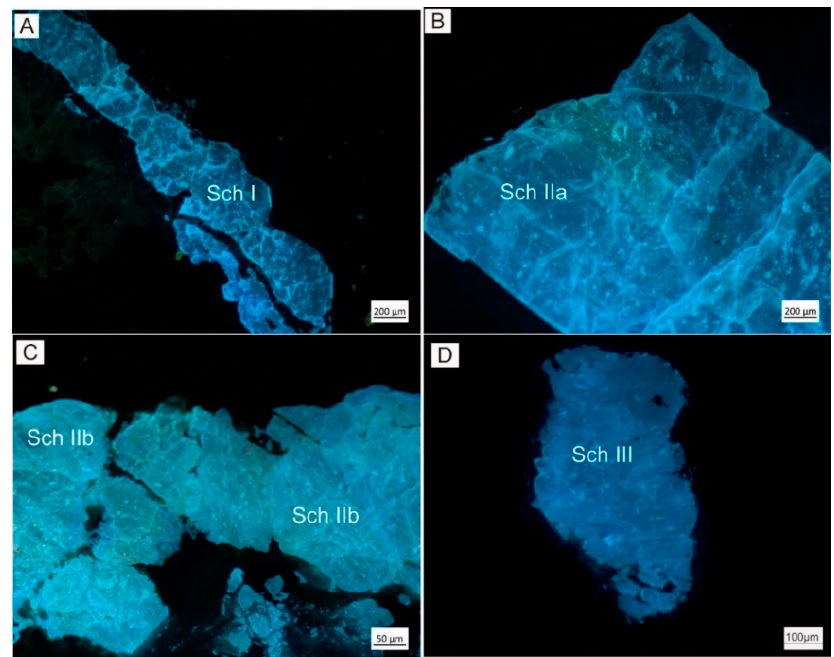
Figure 5. Microphotos under optical-microscopy and coupled cathodoluminescene. ( A ) Anhedral fine grain scheelite replacing wolframite in the tunsten mineralization veins; ( B ) Sub-euhedral coarse grain scheelite from the quartz-scheelite veins in the slate; ( C ) Sub-euhedral coarse grain scheelite and fractured scheelite from the quartz-scheelite vien in the slate, typical hydrothermal fluids altered the scheelite along the edge of scheelite; ( D ) Anhedral coarse grain scheelite from the quartz-sheelite veins in the sandstones. Abbreviation: Sch-scheelite.